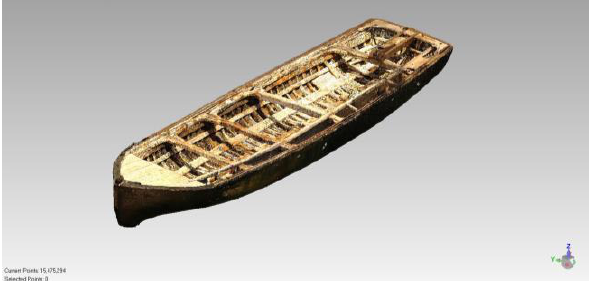
Figure 10. Point cloud of the ‘sciere ’ in Portopalo di Capo Passero.